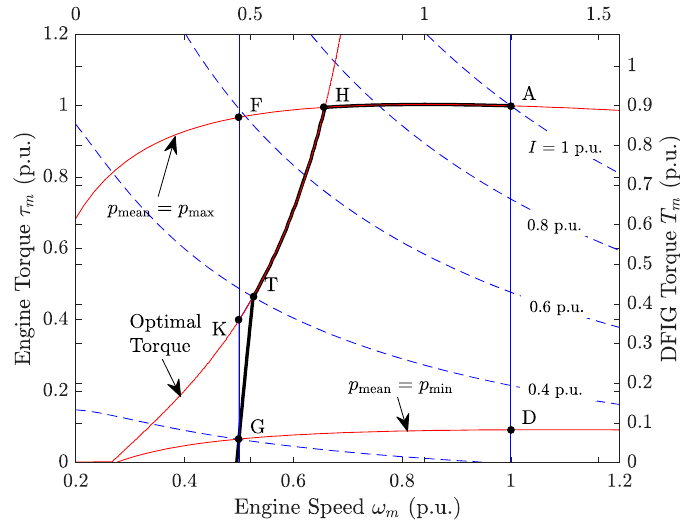
Figure 5. Optimal torque vs engine speed relationship.